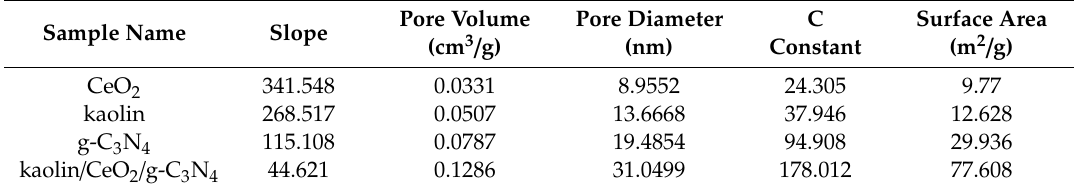
Table 1. Textural characteristics of the nanocomposites determined from nitrogen sorption